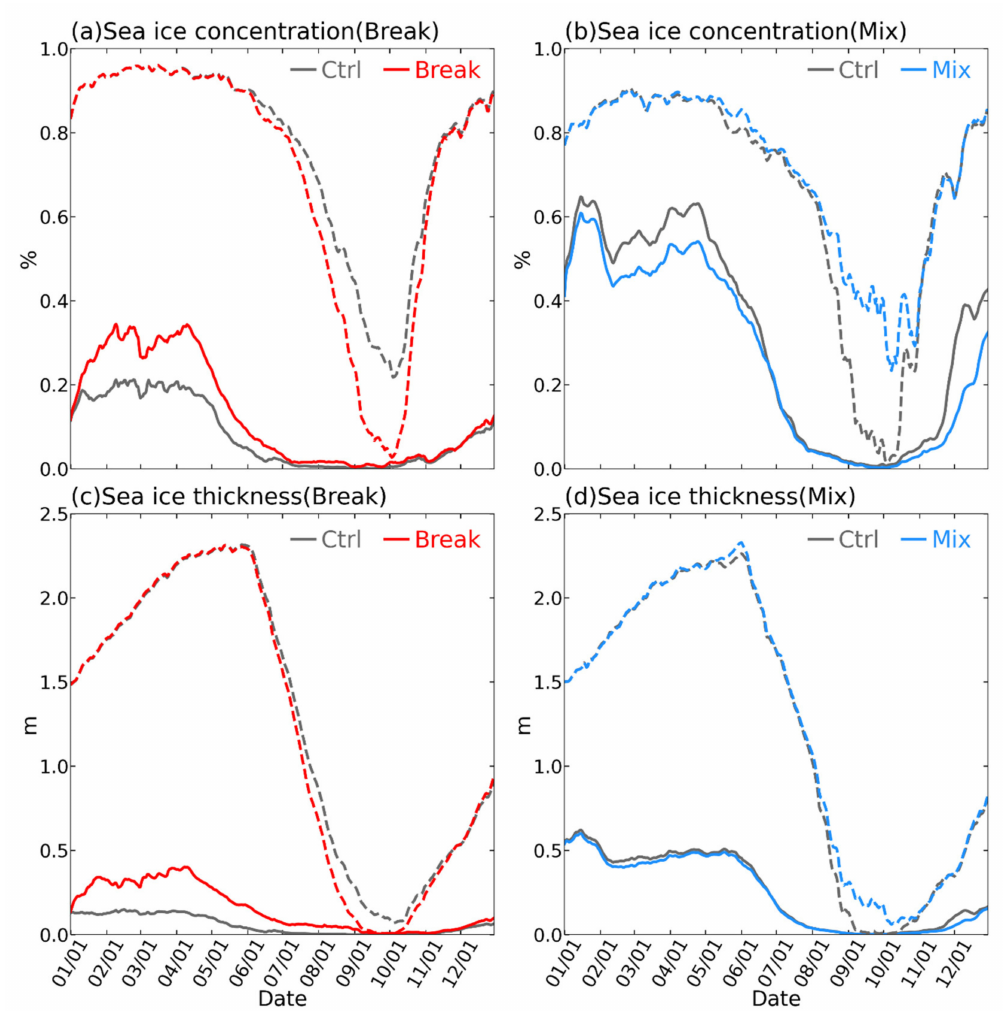
Figure 6. ( a ) Averaged sea ice concentration from the Ctrl (gray) and Break (red) experiments over the Break_Winter (solid line) and Break_Summer (dash line). ( b ) Averaged sea ice concentration from the Ctrl (gray) and Mix (blue) experiments over the Mix_Winter (solid line) and Mix_Summer (dash line). ( c , d ) Same as ( a , b ), but for the sea ice